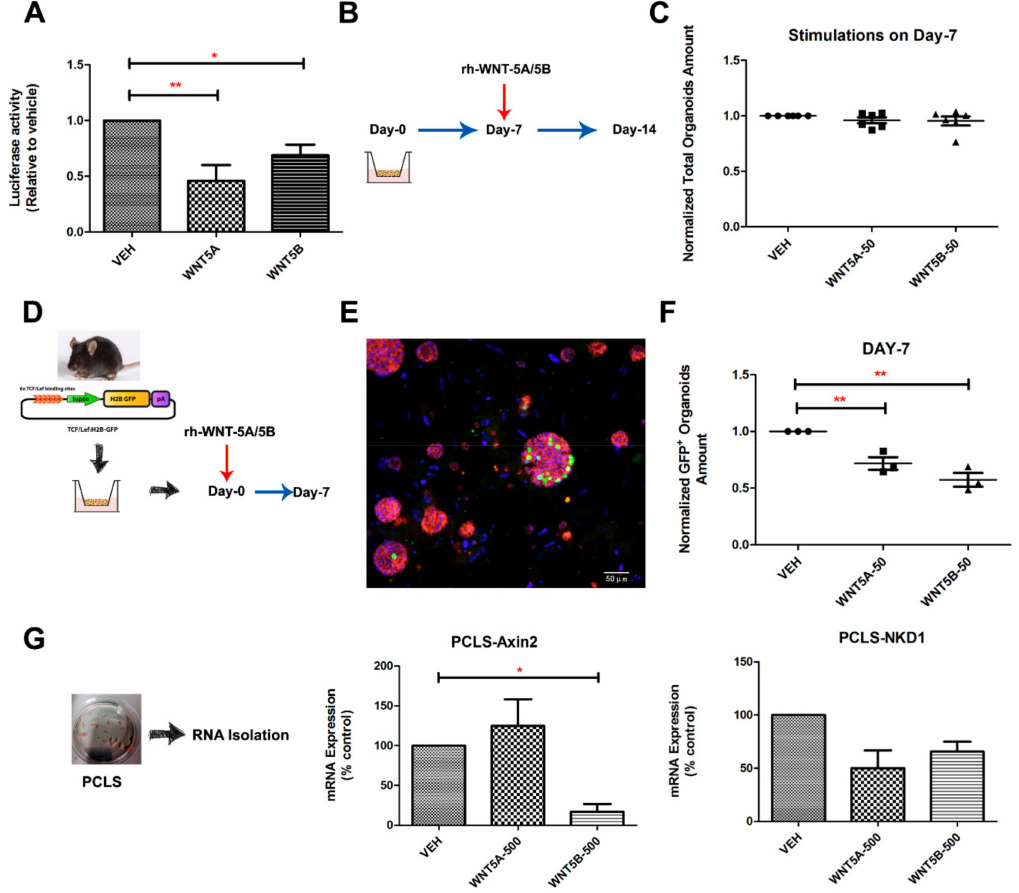
Figure 5. WNT-5A and WNT-5B impaired the WNT / β -catenin signaling in murine lung. ( A ) WNT-5A attenuated the β -catenin-dependent gene transcription (TOP / FOP-flash assay) in human alveolar epithelial cells. N = 4 experiments, one-way ANOVA analysis. ( B ) Schematic of mouse organoid experimental design with a late (start on day 7) stimulation of WNT-5A or WNT-5B (0-, 50 ng / mL). ( C ) Quantification of total murine organoids on day 14 with delayed stimulations of WNT-5A or WNT-5B (0 and 50 ng / mL). ( D ) Schematic of experimental design with TCF / Lef: H2B-GFP transgenic mice. ( E ) Quantification of GFP + organoids on day 7 treated with recombinant WNT-5A or WNT-5B (0 and 50 ng / mL). ( F ) Representative images of GFP + organoids (WNT responsive organoids) from WNT-5A and WNT-5B stimulations, green (TCF:GFP), blue (DAPI). ( G ) Normalized gene expression of AXIN2 and NKD1 on murine lung slices treated with WNT-5A or WNT-5B (0 and 500 ng / mL). Data are expressed as mean ± SEM, * p < 0.05, ** p <